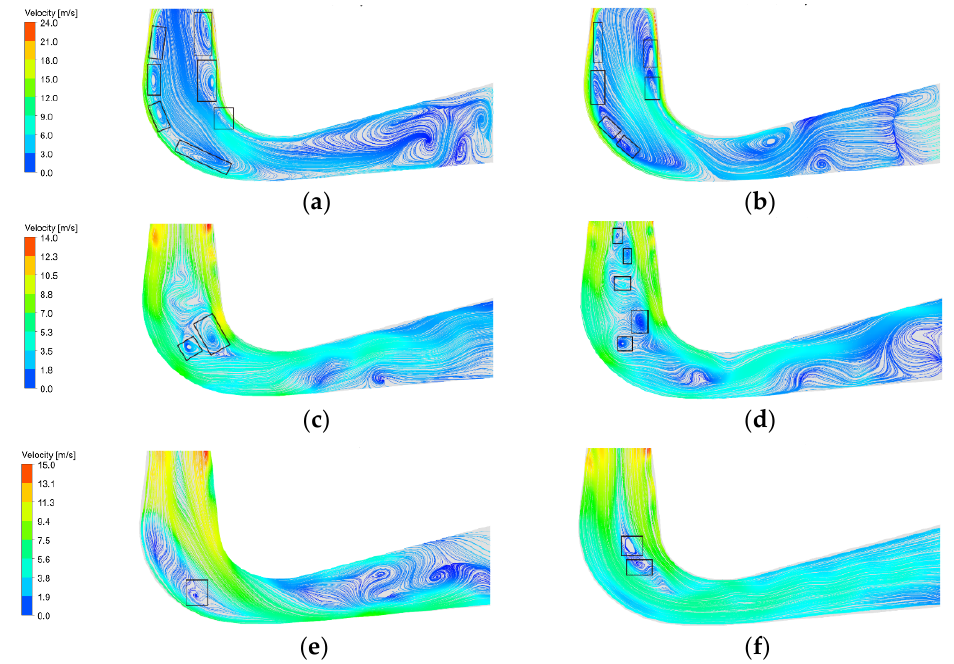
Figure 7. Streamlines at various sections of the draft tube. ( a ) OP1, ( b ) OP2, ( c ) OP3, ( d ) OP4, ( e ) OP5, and ( f ) OP6.